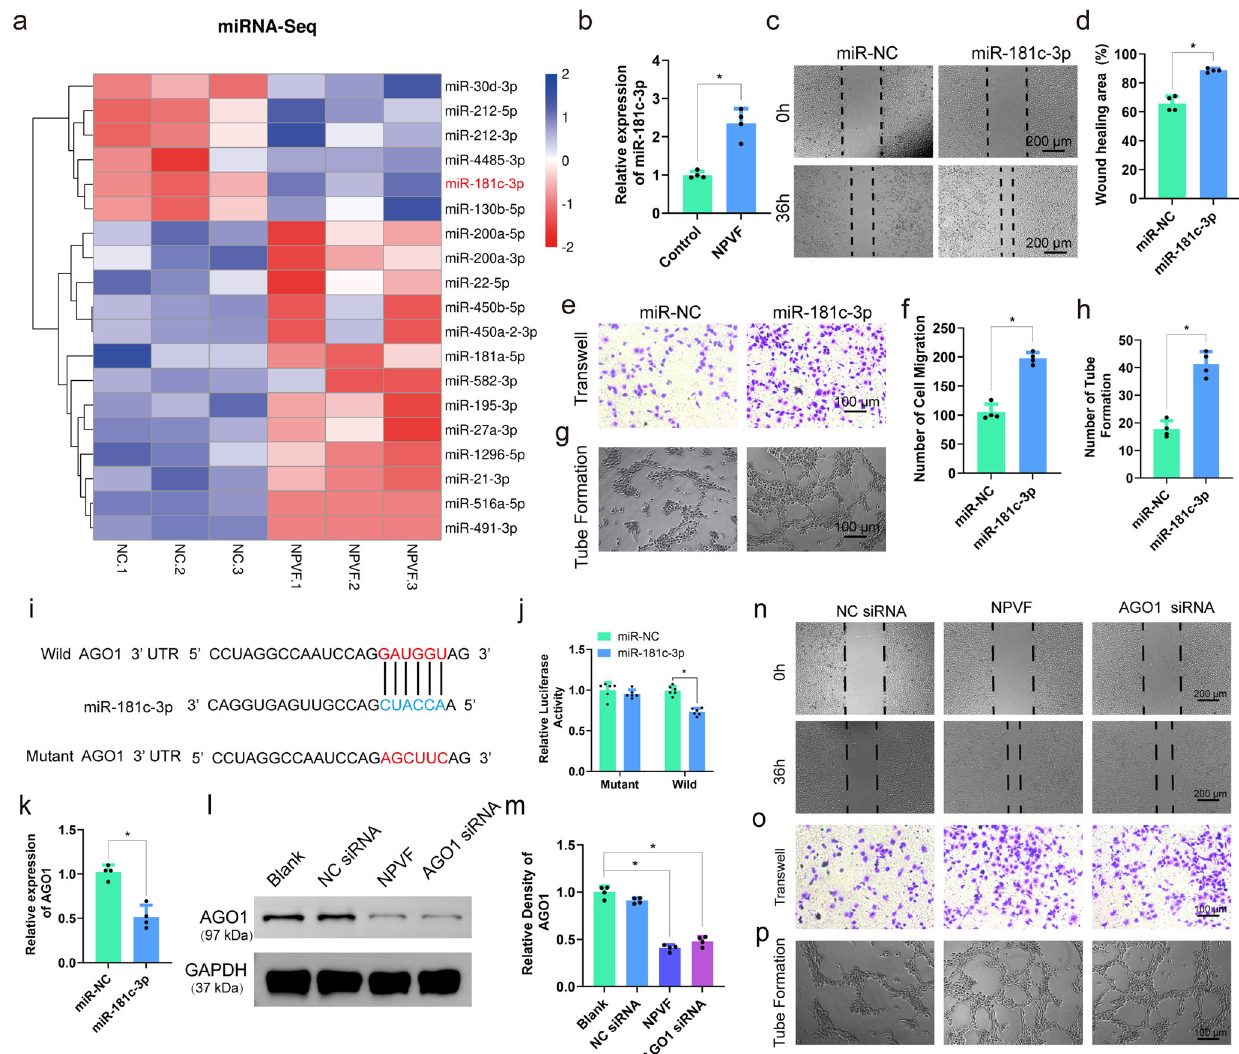
Fig. 3 miR-181c-3p mediates the NPVF neuropeptide-induced migration and tube formation of HUVECs. a Heatmap of miRNA sequencing results for HUVECs treated with NPVF (48 h). The color represents the relative expression value of miRNA genes. b The gene expression level of miR-181c-3p in HUVECs after treatment with NPVF. Results are presented as means ± S.E.M. of four independent experiments, and the P value is 0.0005. * P <